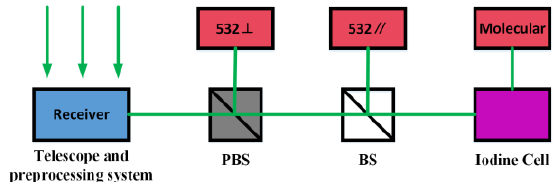
Fig.1 A general 532nm iodine HSRL system block diagram with abstract